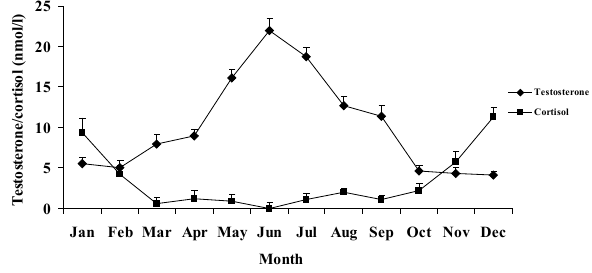
Figure 1. Variations in plasma testosterone and cortisol level in samples (mean ± SEM) collected monthly in Syrian Awassi rams ( n = 10).